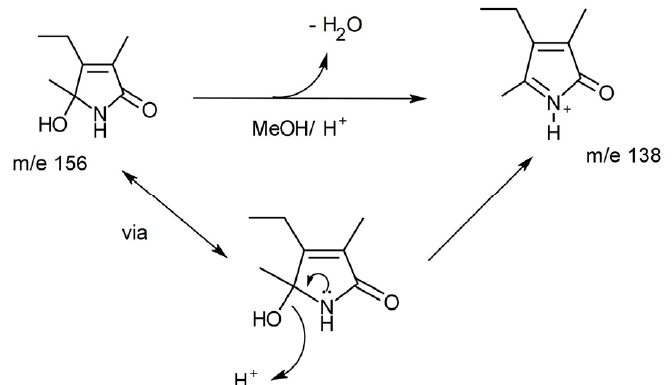
Figure 3. The hydroxylactam of haem pyrrole (“HPL”, m/e156) dehydroxylates under mildly acidic conditions (such as those encountered in typical LC-MS) to the m/e ion shown above.